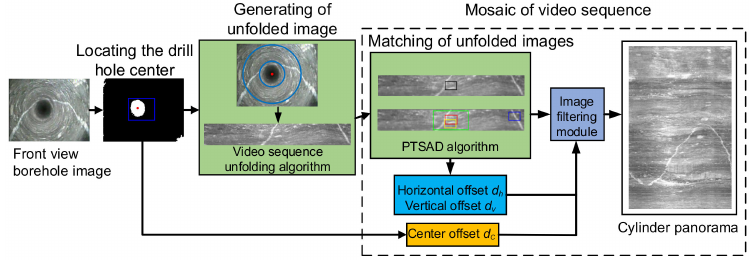
Figure 1. Flowchart describing the system overview.